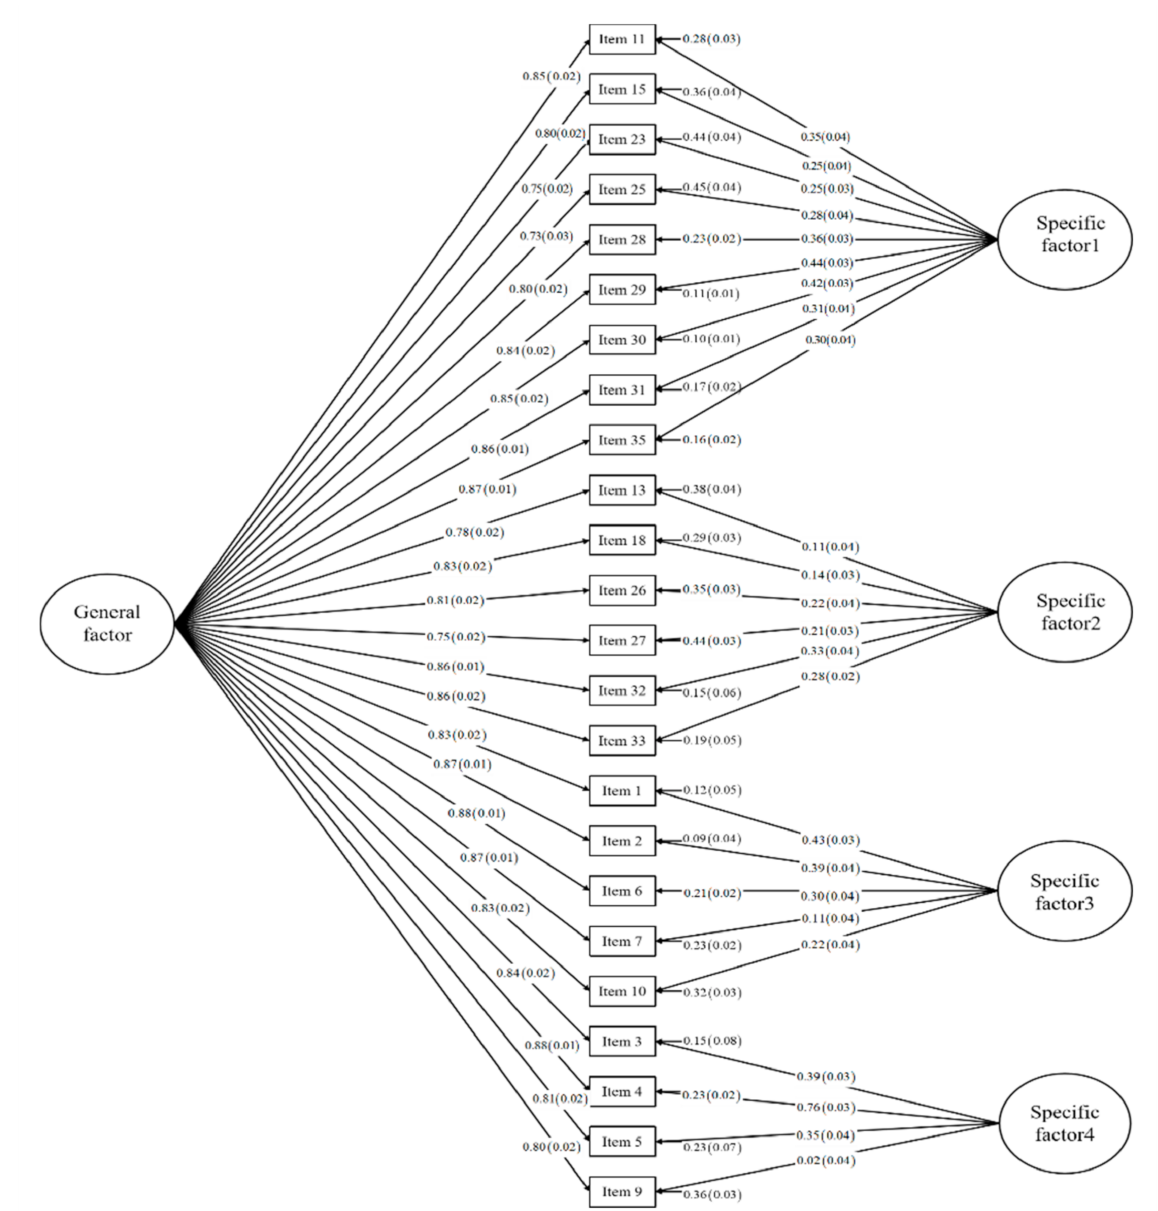
Figure 2. Bifactor structure of the DERS: Item-factor loadings from the ideal CFA solution ( N = 1036). Note: Specific factor1 = Non-acceptance; Specific factor2 = Goals; Specific factor3 = Awareness; Specific factor4 =